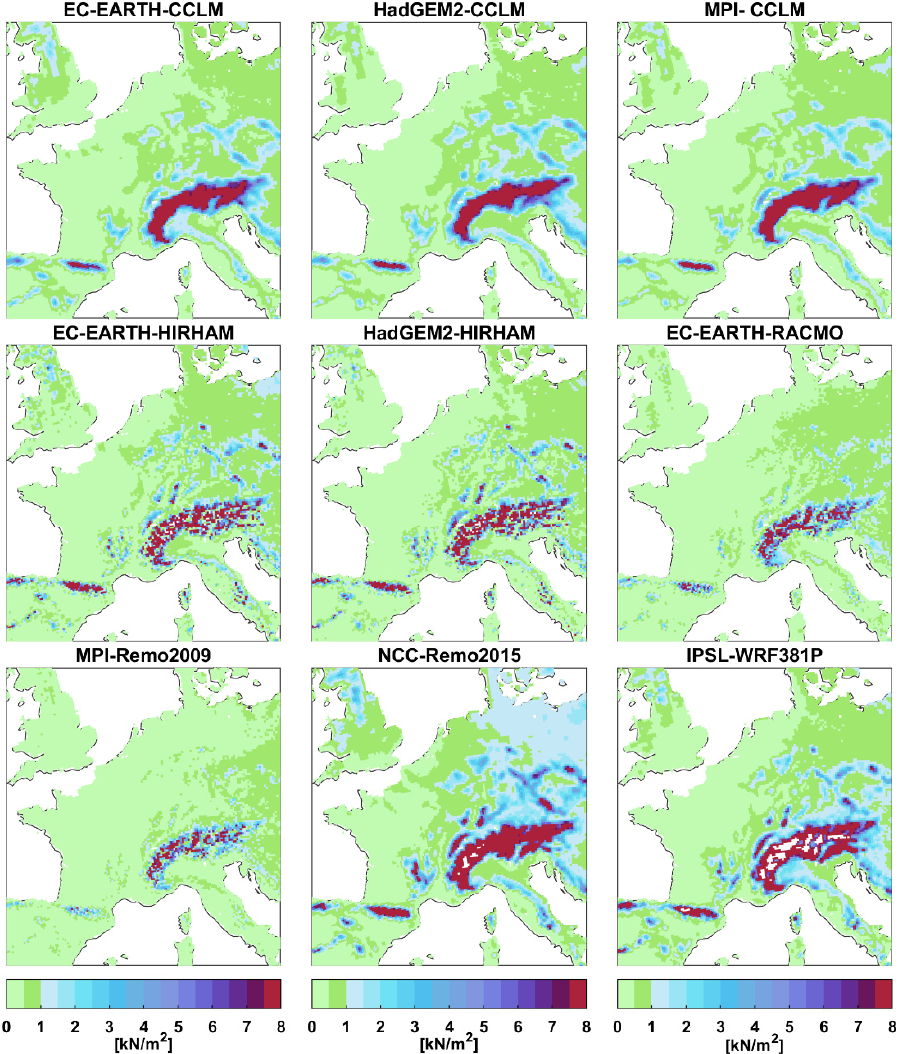
Figure 2. Characteristic ground snow load maps, showing load values associated to 0.02 probability of exceedance in one year, elaborated from the analysis of the nine climate models, described in Table 1, considering the period 1951–1990.